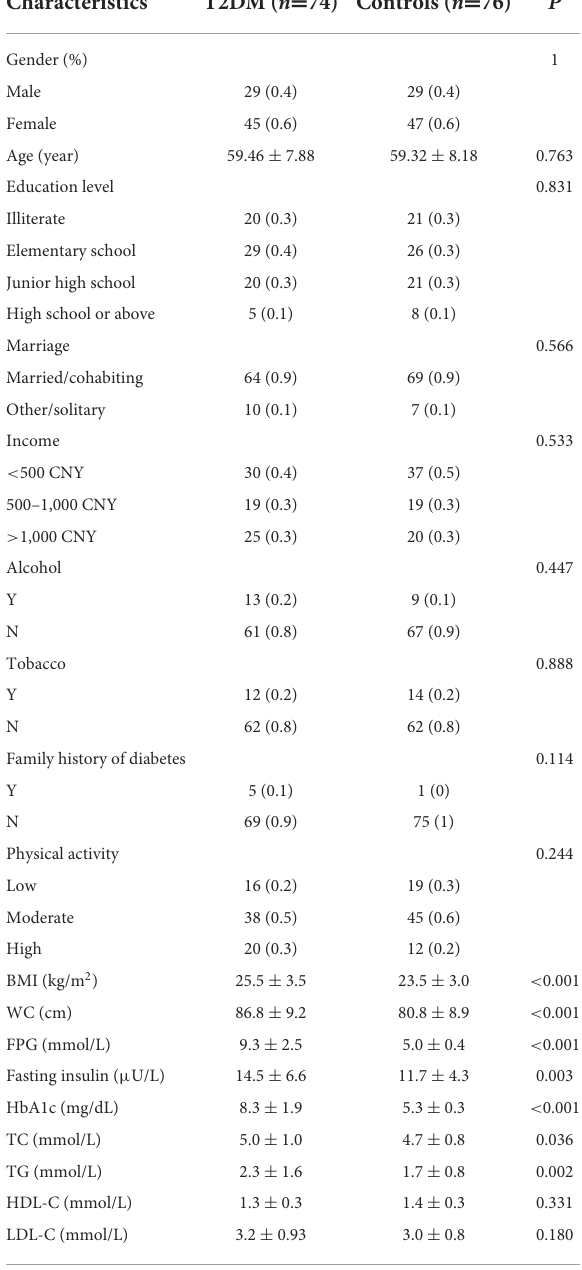
TABLE 1 Characteristics of T2DM cases and controls.